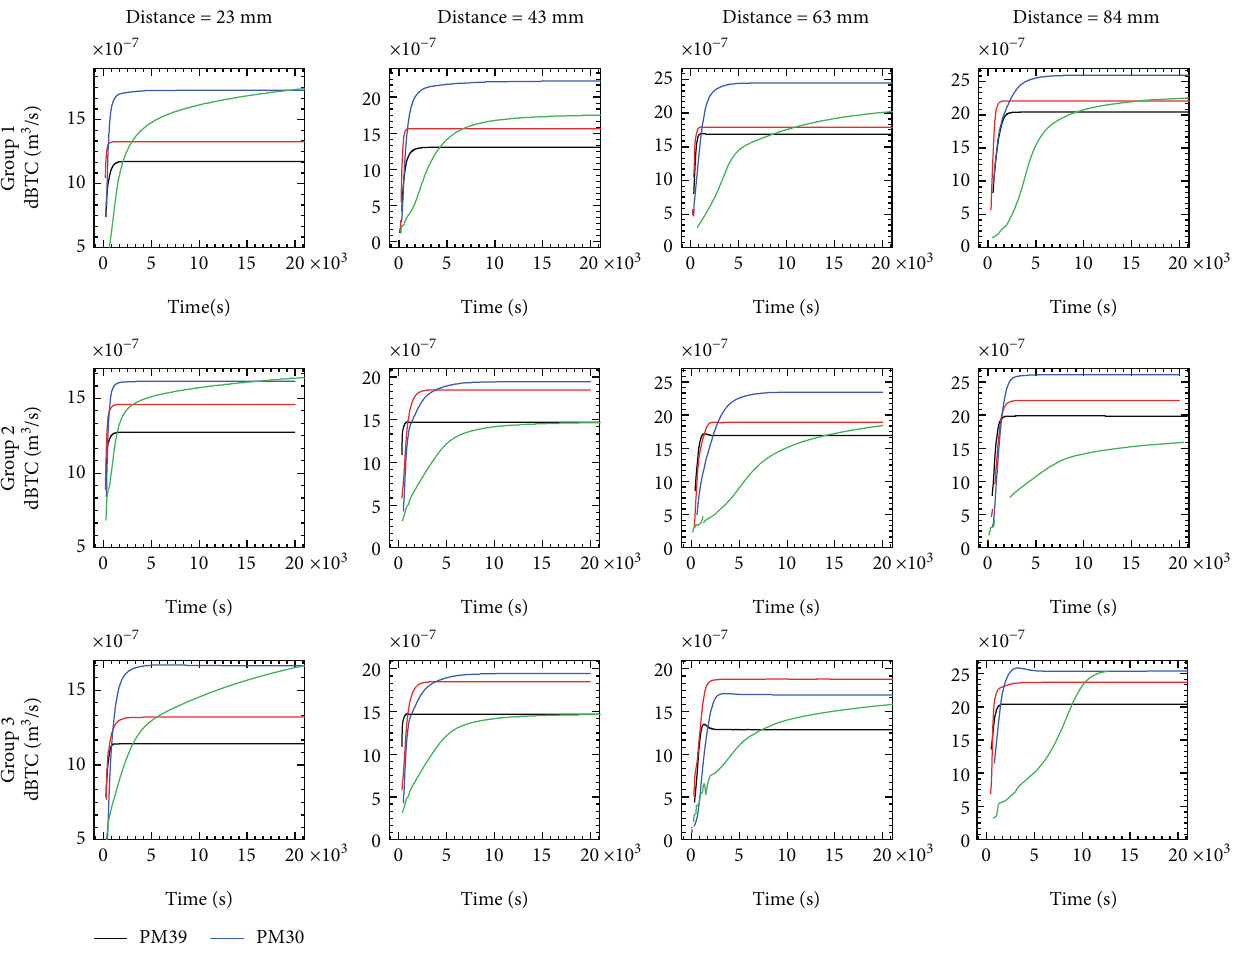
Figure 3: Dilution breakthrough curves (dBTCs) at di ff erent cross-sections located at various distances from the tracer source in all four types of porous media: 23 mm, 43 mm, 63mm, and 84mm. Di ff erent rows are the simulation results for three sets of di ff erent porous media (Group 1, Group 2, and Group